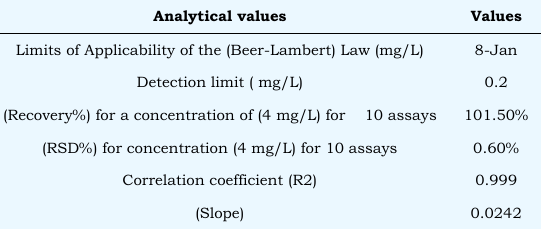
Table 4 The results of the examination of analytical samples by the traditional method and (RGB) method with a smartphone Analytical samples